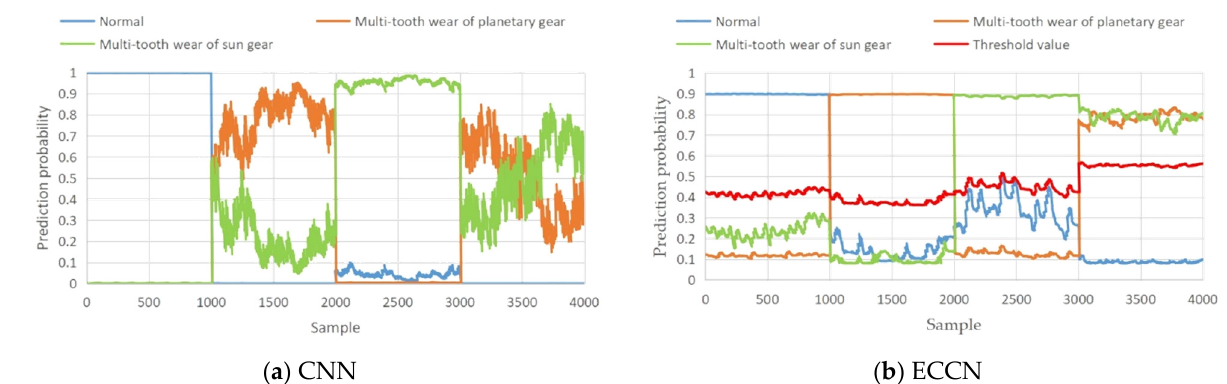
Figure 13. The predicted probability of the model output ( a ) CNN; ( b ) ECCN.